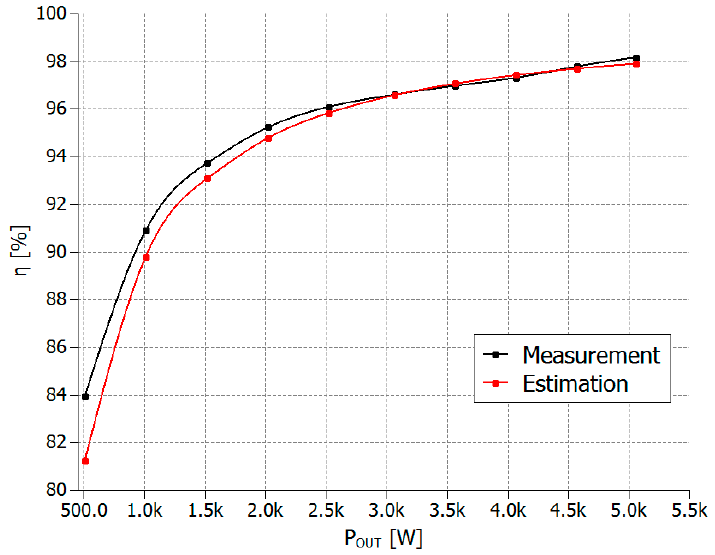
Figure 19. The estimated and measured energy efficiency characteristics of the tested DAB con- verter for the case when energy is transferred from bridge H 2 to H 1 .